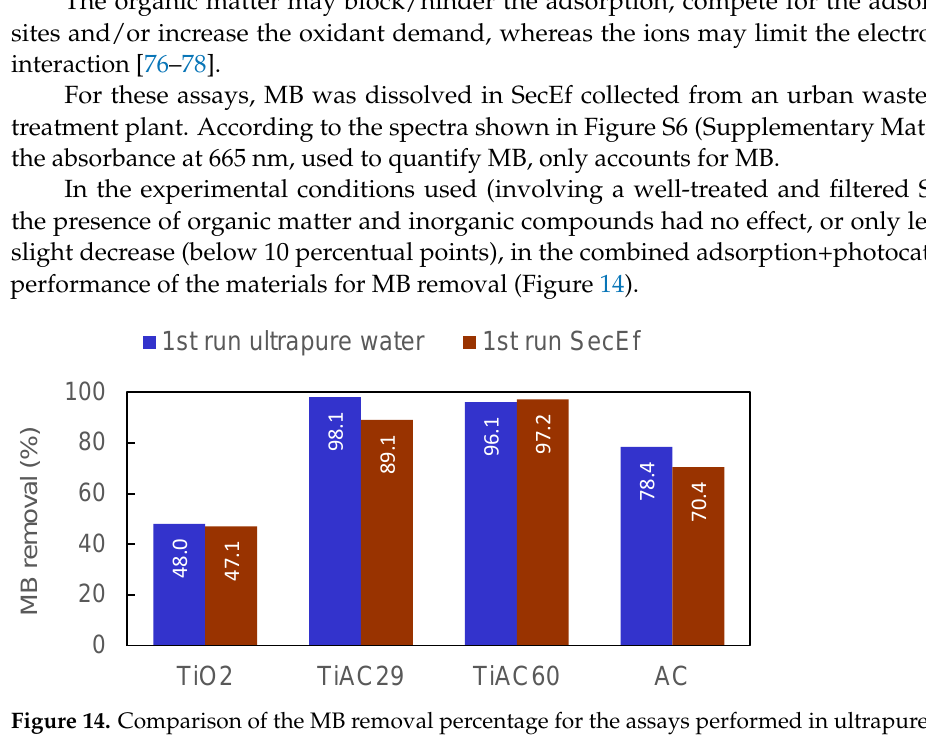
Figure 15. DOC ( a ), A254 ( b ), A436 ( c ) and A665 ( d ) of the SecEf after adsorption and adsorption+photocatalysis, and of the SecEf spiked with MB after adsorption+photocatalysis (25 mg/L MB and contact time = 90 min).